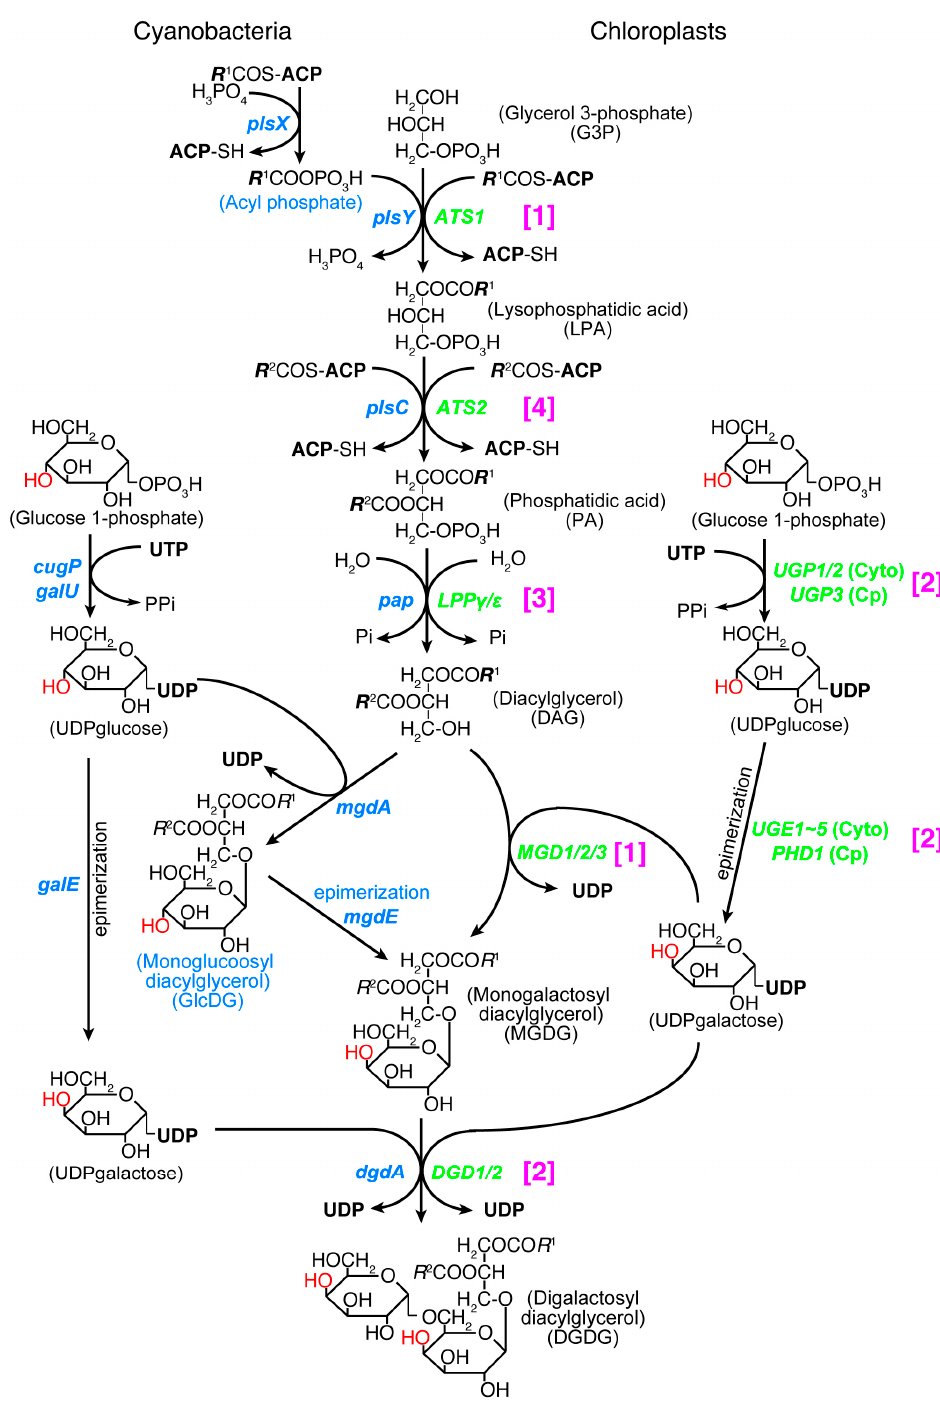
Figure 2. Glycolipid biosynthesis pathways in cyanobacteria and chloroplasts. The distinction between galactose and glucose is shown by the 4’-OH group in red. Cyanobacterial genes are shown in cyan, whereas eukaryotic or non-cyanobacterial genes are shown in green. Note that the biochemical reactions are different in the two steps marked [1] in magenta. In other steps, biochemically identical reactions are catalyzed by structurally unrelated (isofunctional non-homologous) enzymes marked [2]. Eukaryotic paralogs and phylogenetically distant orthologs are marked [3] and [4], respectively.